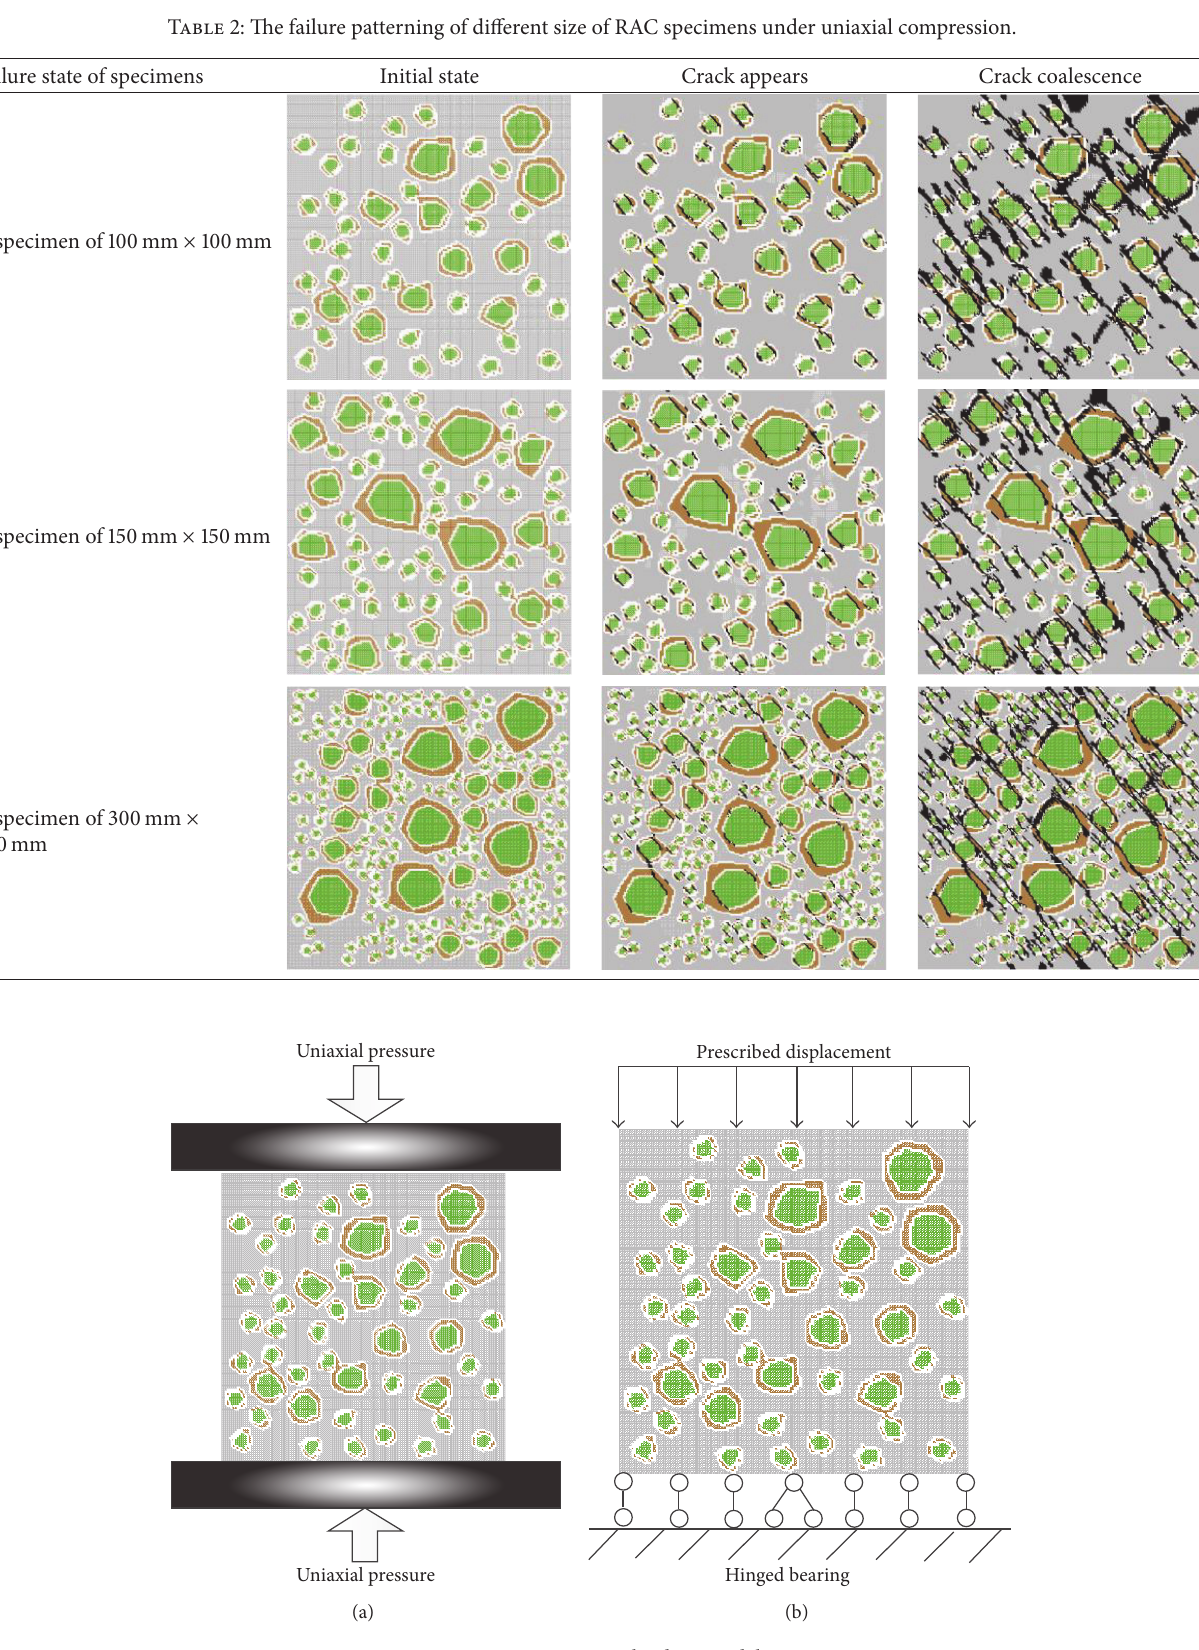
Figure 6: Compressive loading